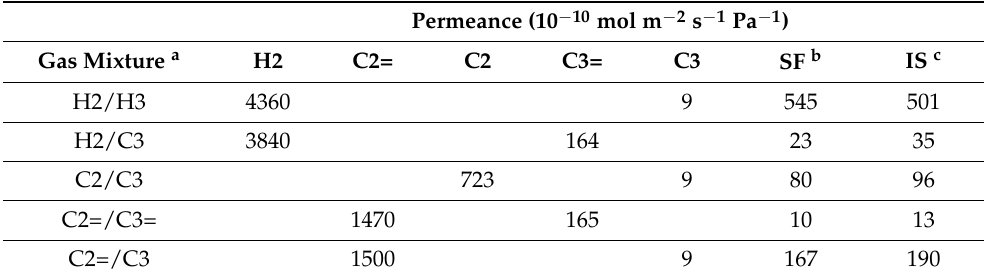
Table 1. The mixed-gas permeation features of ZIF-8 membranes at room temperature (~23 ◦ C) with different binary gas mixtures